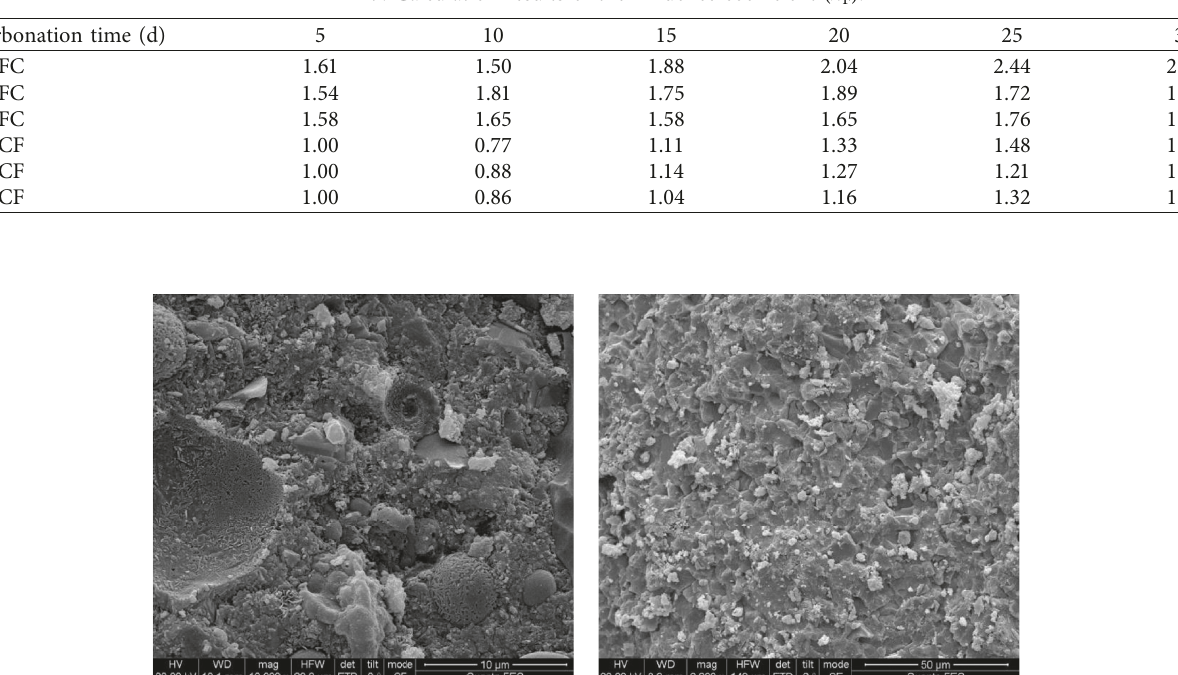
Table 7: Calculation results of the influence coefficient ( λ